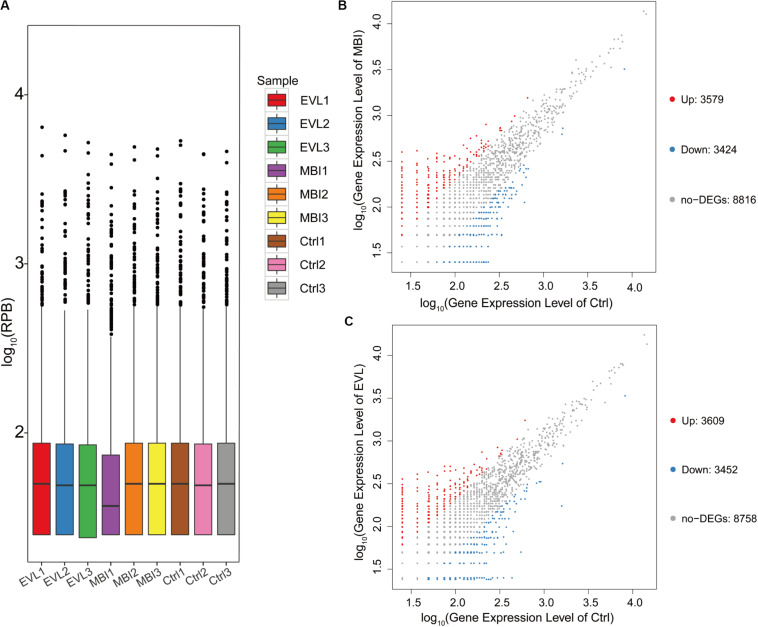
Differential expression of circRNAs in rat retinas. (A) Box plot showing the distribution of circRNA expression values in 9 samples from the EVL, MBI and Ctrl groups (EVL, episcleral vein ligation, n = 3; MBI, microbead injection, n = 3; Ctrl, control, n = 3). (RPB, reads per billion) (B) Scatter plot of expression level in MBI and Ctrl groups showed differentially expressed circRNAs selected with an absolute log2 (fold change) > 1 and q < 0.001. (C) Scatter plot of expression level in EVL and Ctrl groups showing differentially expressed circRNAs selected with an absolute log2 (fold change) > 1 and q < 0.001. The red points on the left indicate the upregulated circRNAs, while the blue points indicate the downregulated circRNAs. The gray points in the middle exhibited no significant difference between the COH (chronic ocular hypertension) models and Ctrl group with absolute log2(FC) < 1 or q > 0.001.